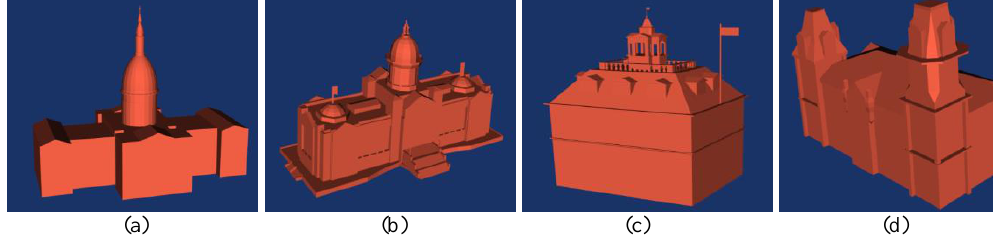
Figure 4. Original building models without texture